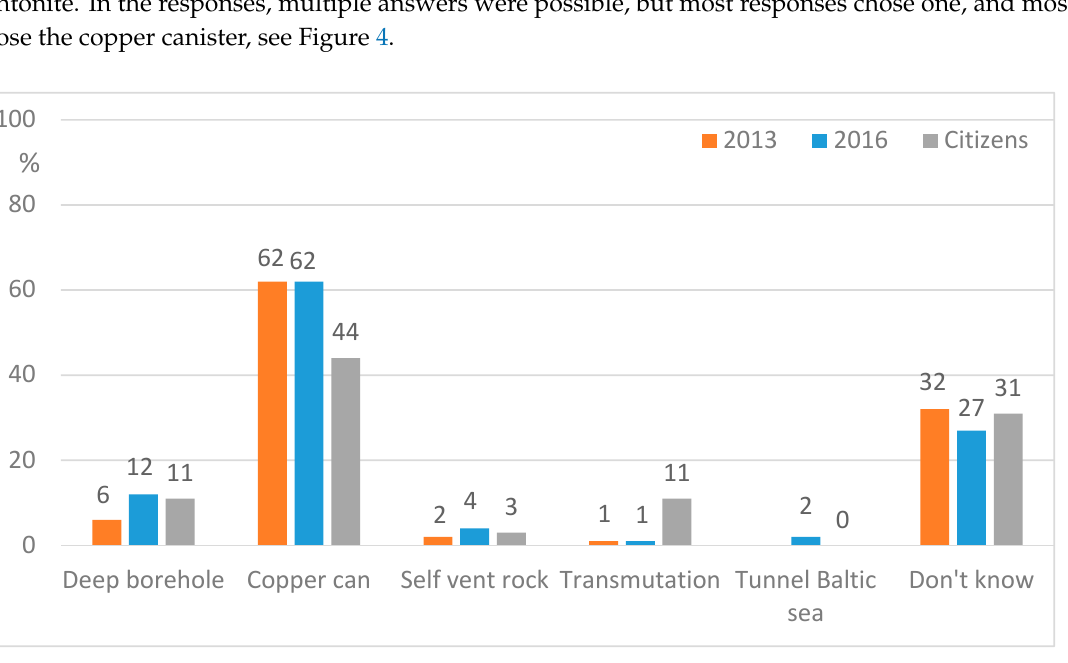
Figure 4. Which solution for final repository does SKB suggest in its application concerning spent nuclear fuel?